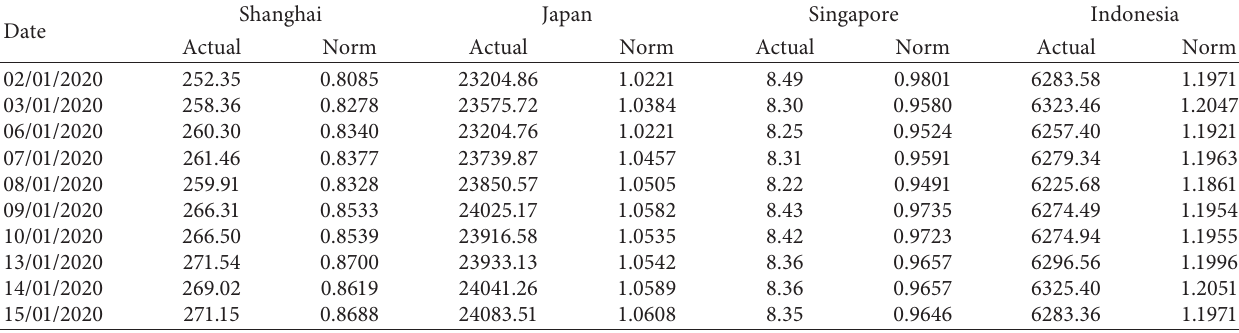
Table 1: Snapshots of daily stock market indices used as multiple financial time-series data.